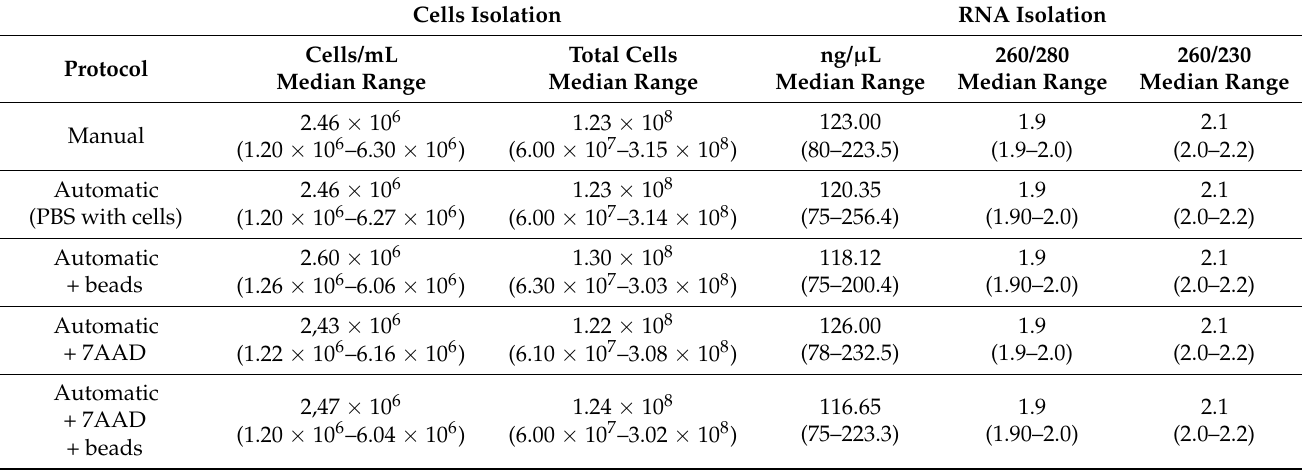
Table 2. Comparison of the amount of white blood cells and RNA isolated in matched samples by five different counting